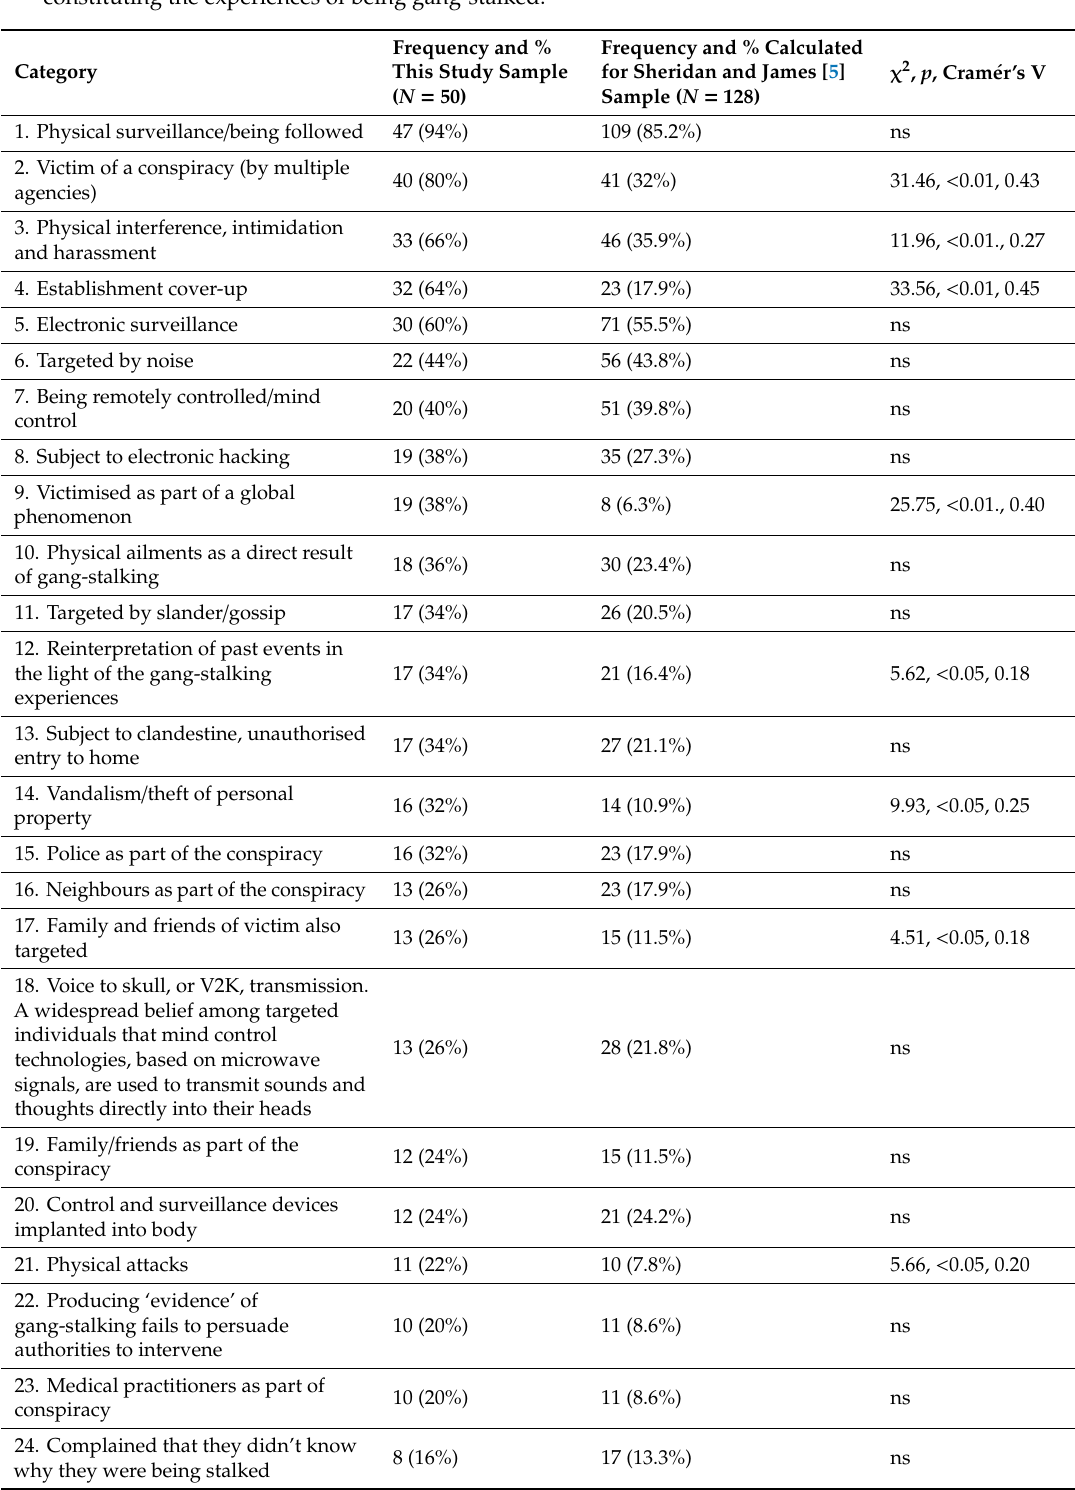
Table 3. Comparisons between content analyses of internet and questionnaire samples on phenomena constituting the experiences of being